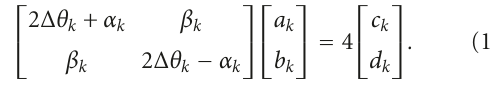
The amplitude error (6) is a function of the input